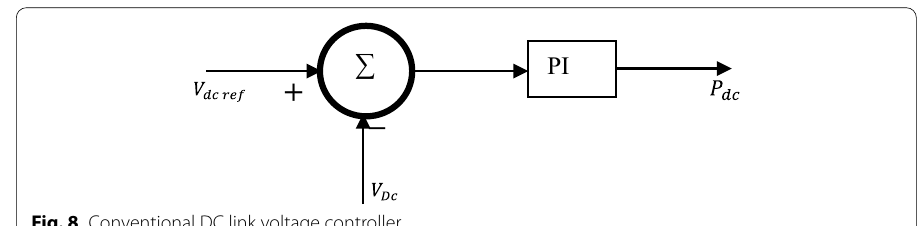
Fig. 8 Conventional DC link voltage controller